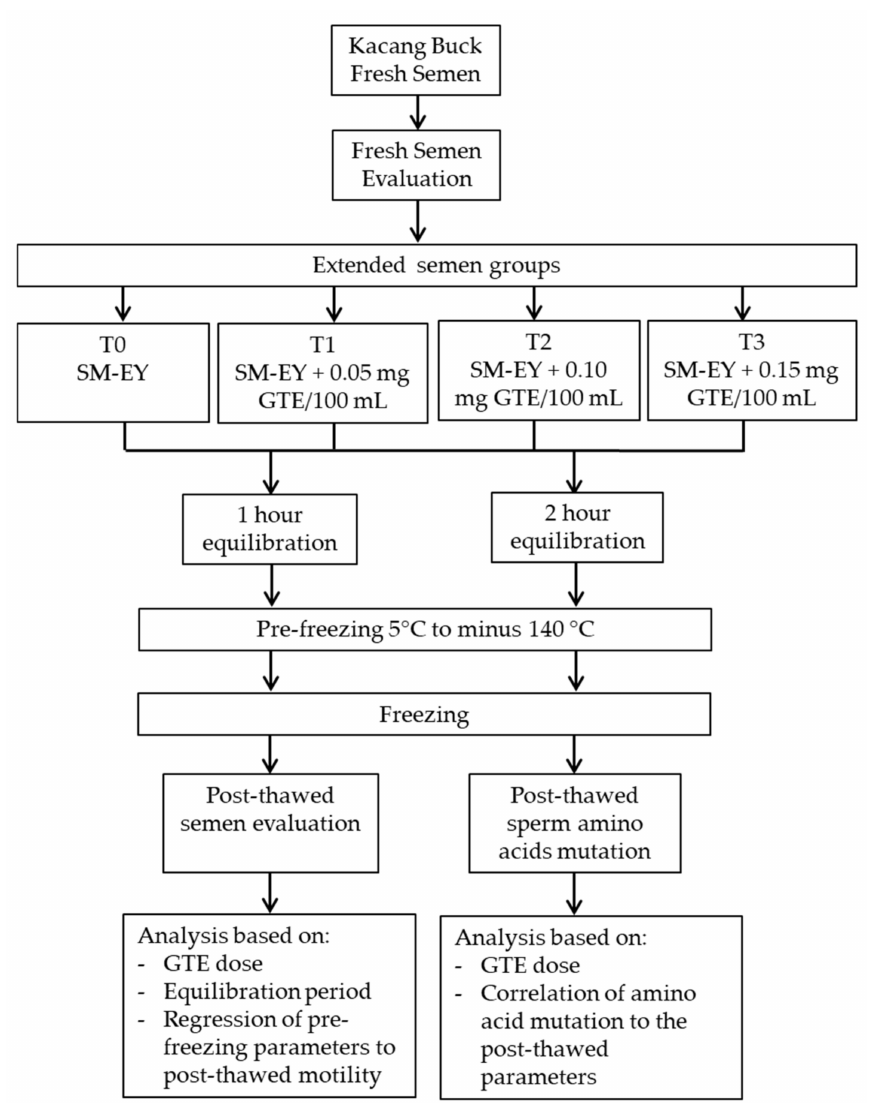
Figure 1. Work flow of the study of the green tea extract in the extender improved the post-thawed semen quality and decreased amino acid mutation of Kacang buck